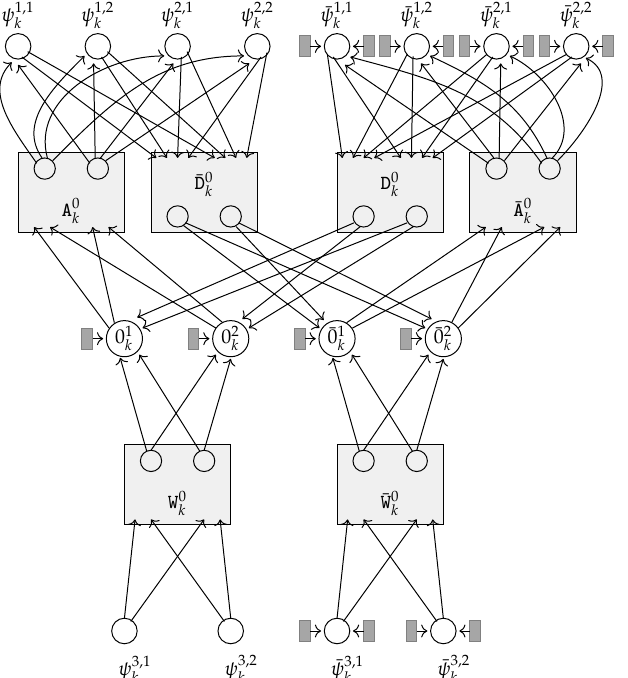
Figure 4. Example of the part of subgraph G k , for some 1 ≤ k ≤ N , related to cell nodes 0 1 and ¯0 1 , ¯0 2 when the quintuples in P (listed with their order number) are: (1): (cid:104) q 0 ,0,1, q 0 , left (cid:105) , k k (2): (cid:104) q 1 ,0,1, q 0 , right (cid:105) , (3): (cid:104) q 0 ,1,0, q 1 , left (cid:105) , (4): (cid:104) q 1 ,1, b \ , q 0 , right (cid:105) , (5): (cid:104) q 0 , b \ ,1, q 1 , right (cid:105) , (6): (cid:104) q 1 , b \ , b \ , q A , right (cid:105) . For the sake of readability, a machine TM was considered, defined